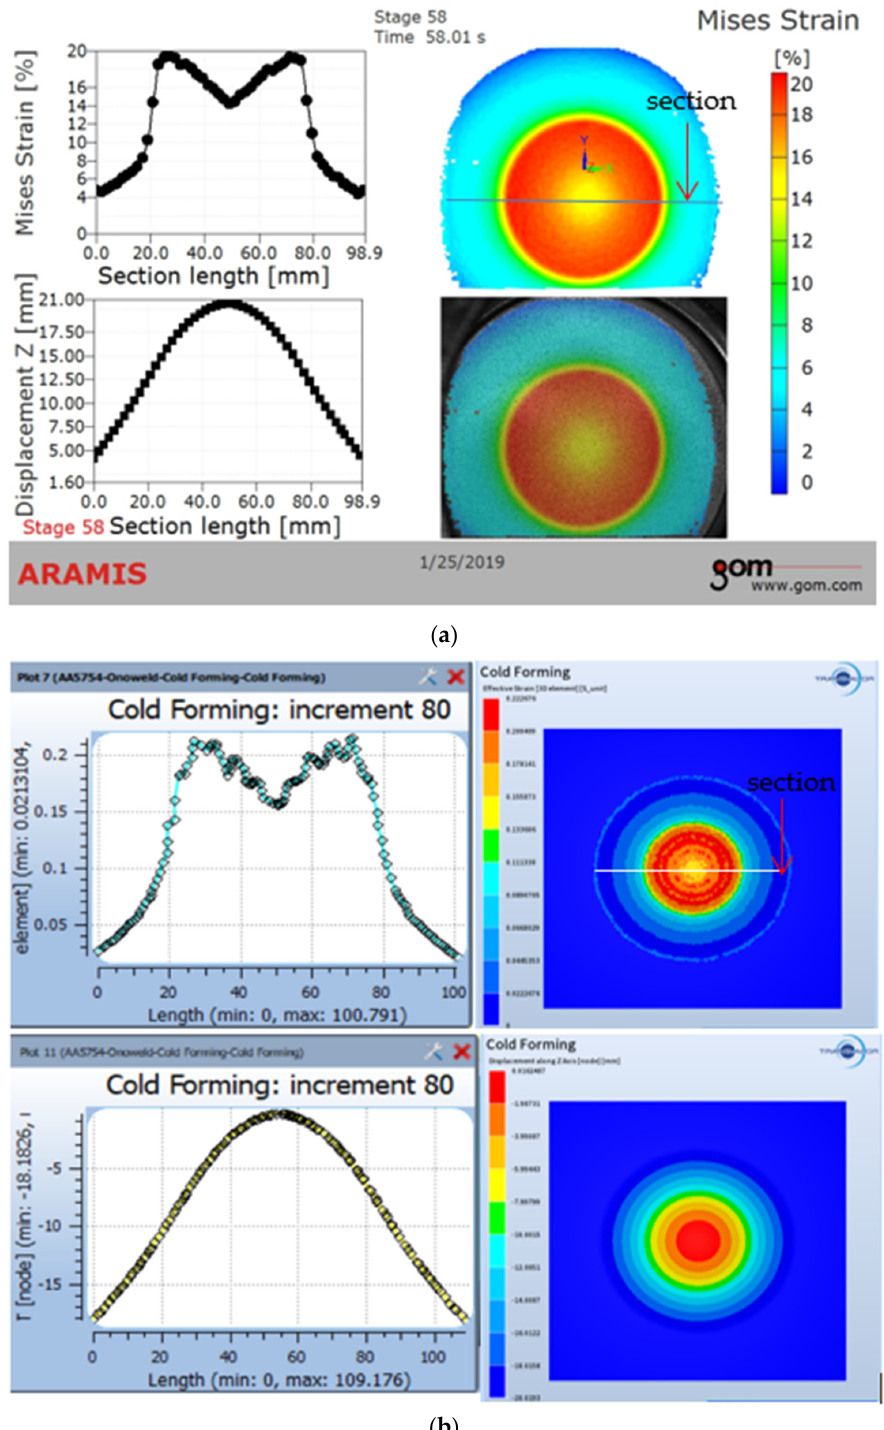
Figure 3. Comparison of Mises strain and displacement across the blank when punch displacement is 20 mm between ( a ) experimental; ( b ) simulation by ForgeNxT 2.1.